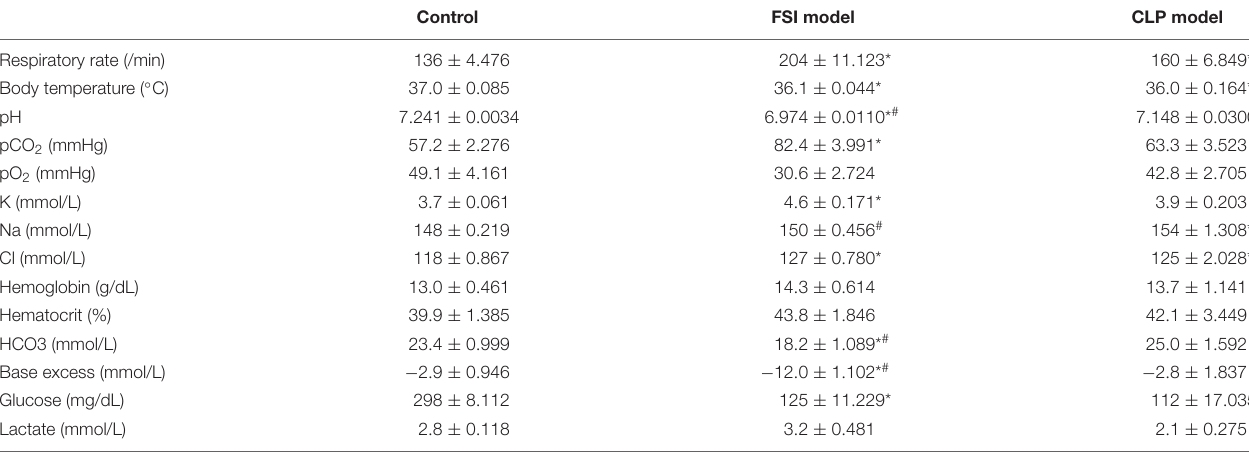
TABLE 2 | Results of the respiratory rate, body temperature, and blood gas analysis 20 h after surgery for FSI and CLP models.